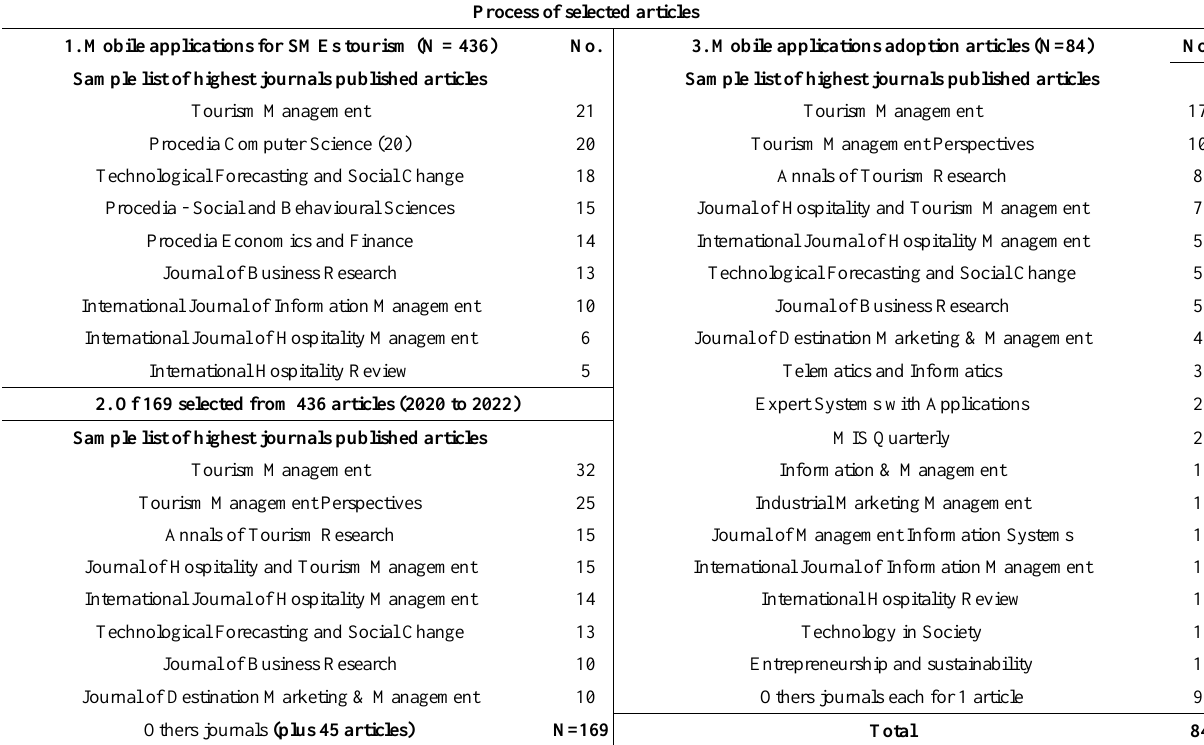
Table 1. Number of publications related to mobile applications during the COVID-19 pandemic (2020 to 2022) Process of selected